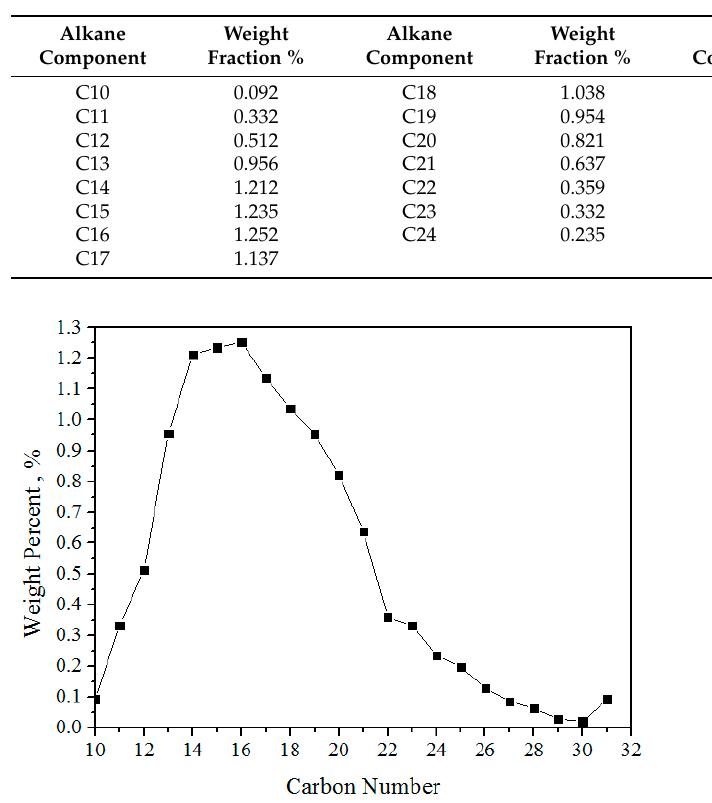
Table 1. Distribution of alkanes in 0# diesel of the Lanzhou Petrochemical Refinery.